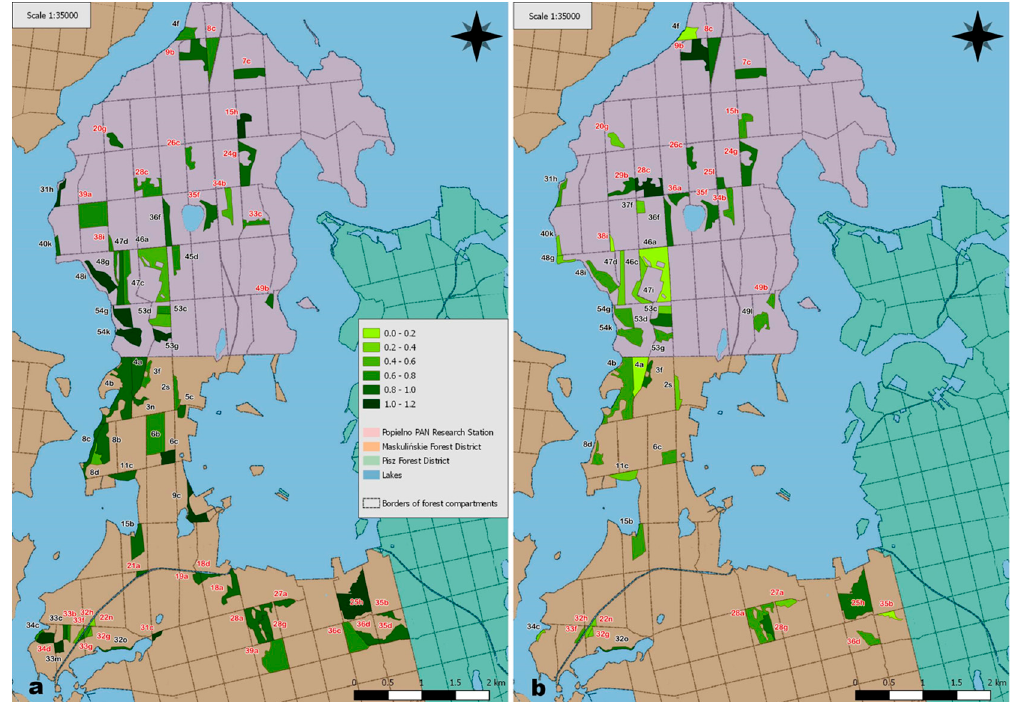
Figure 3. The location of evaluated forest sub-compartments and the graphical interpretation of Shannon ‒ Wiener coefficient for undergrowth below 0.5 m, and herb layer a), and undergrowth higher than 0.5 m shrub layer b); description in the legend.